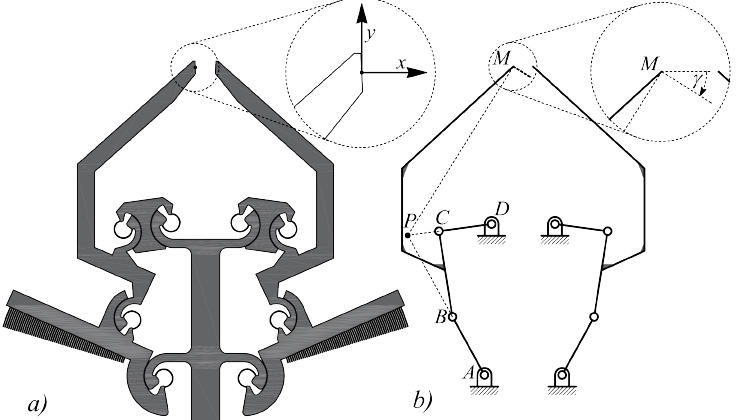
Figure 4. Planar layout ( a ) and functional scheme, PRBM model ( b ), of the second generation microgrippers with a pair of four-bar linkages ABCD , each one having four CSFHs and tip M attached to the coupler link BC . Point P represents the instantaneous rotation center for the coupler BC .